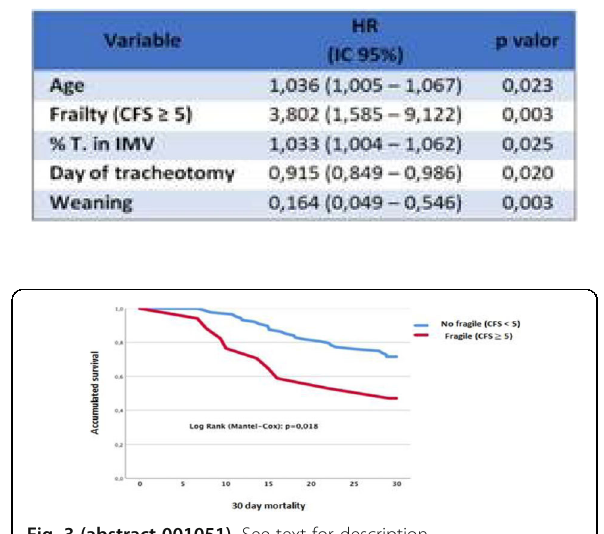
Table 2 (abstract 001051). See text for description